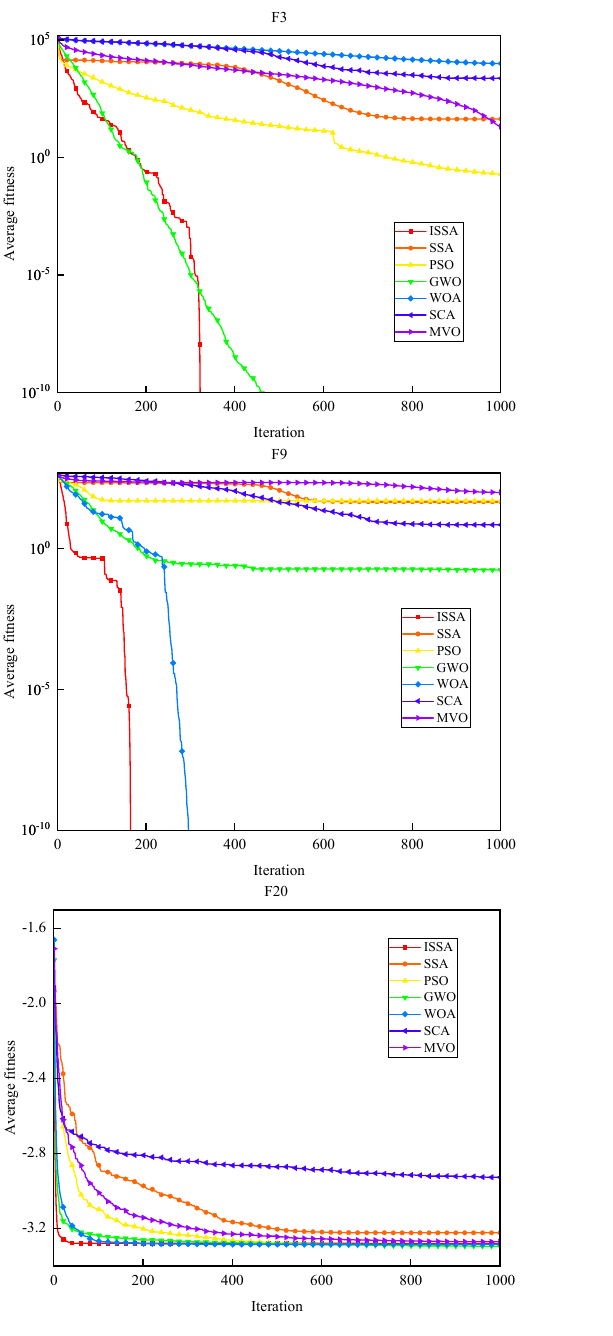
Figure 5. Convergence curves of algorithms for selected six benchmark functions (F3, F4. F9, F10, F20, and F21).